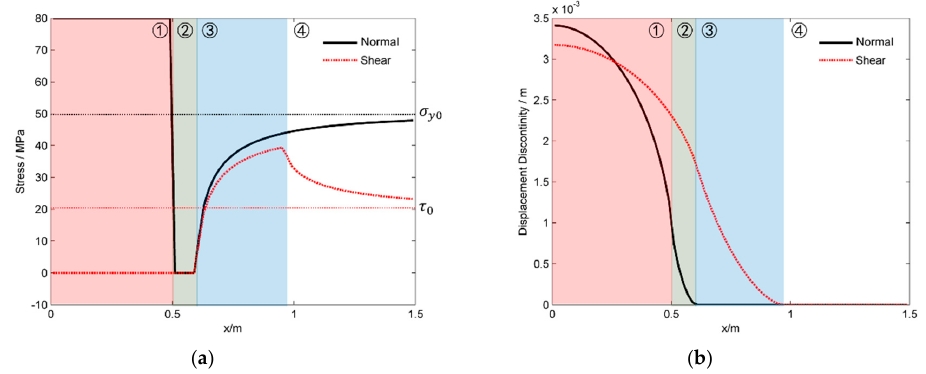
Figure 5. The stress and the displacement discontinuities along the natural fracture when the strength of the natural fracture is assumed to be infinite. ( a ) The normal and shear stresses; ( b ) the normal and shear fracture displacement discontinuities.